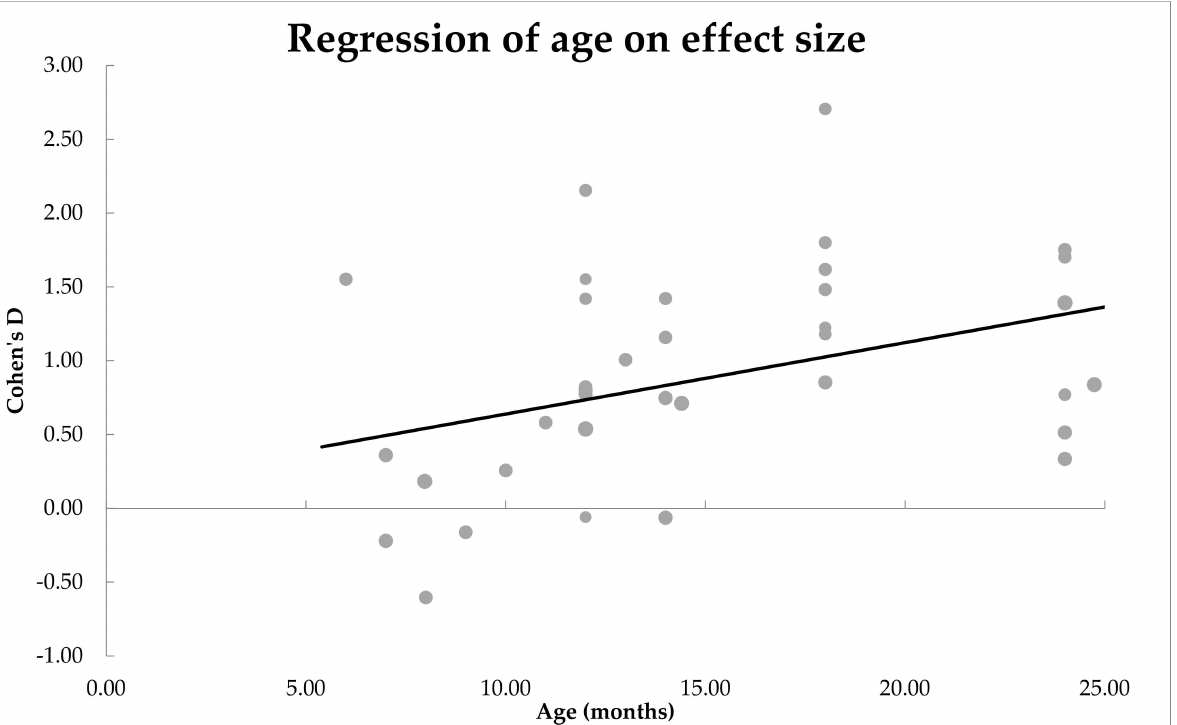
Figure 4. Scatterplot of how age moderated the mean difference between ASD and non-ASD infants’ expressive vocabulary. A significant effect of moderator was